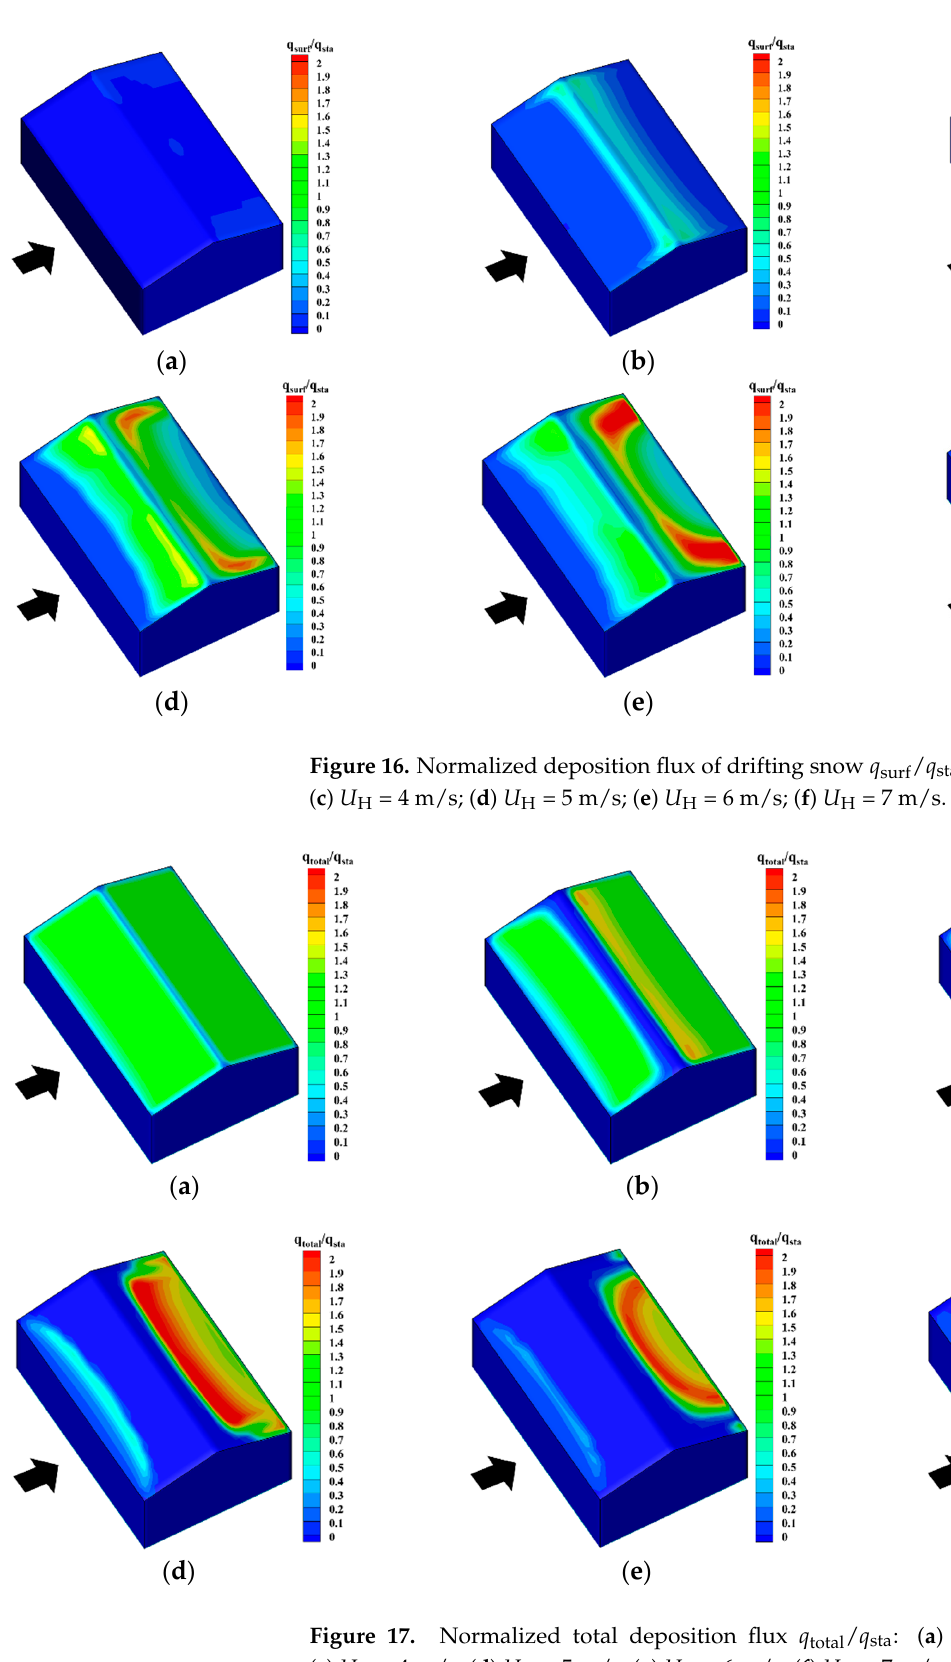
Figure 15. Normalized deposition flux of falling snow q sky / q sta : ( a ) U H = 2 m/s; ( b ) U H = 3 m/s; ( c ) U H